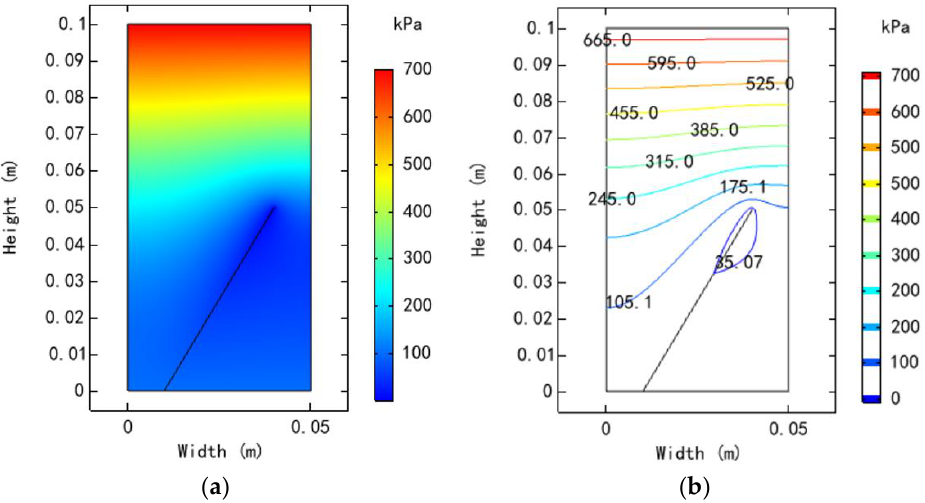
Figure 17. Distribution of gas pressure in the lower fracture model. ( a ) Gas pressure nephogram; ( b ) gas pressure isoline.